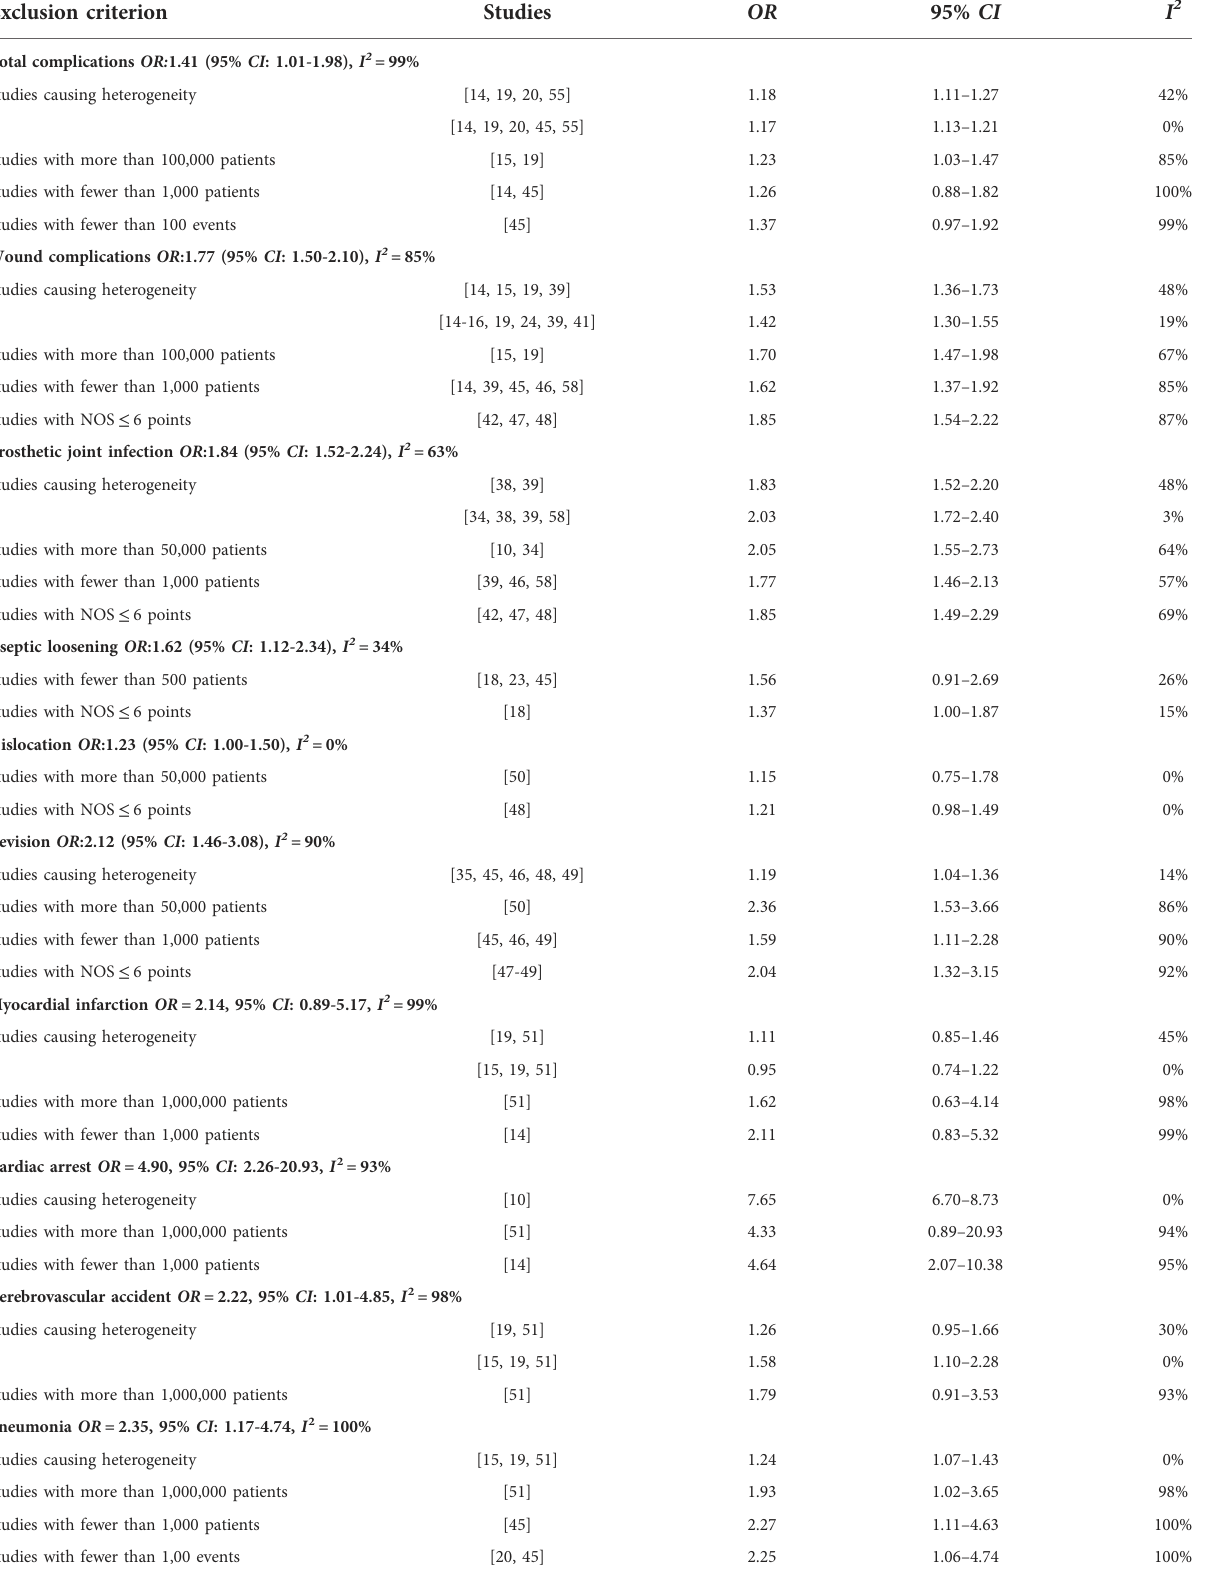
TABLE 3 Results of sensitivity